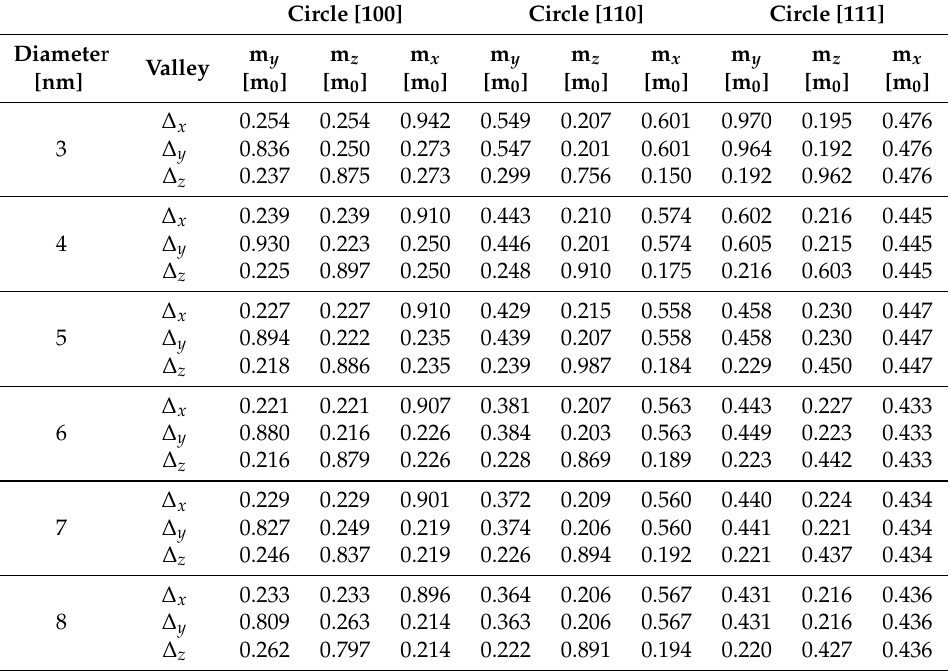
Table 2. Effective masses for circular